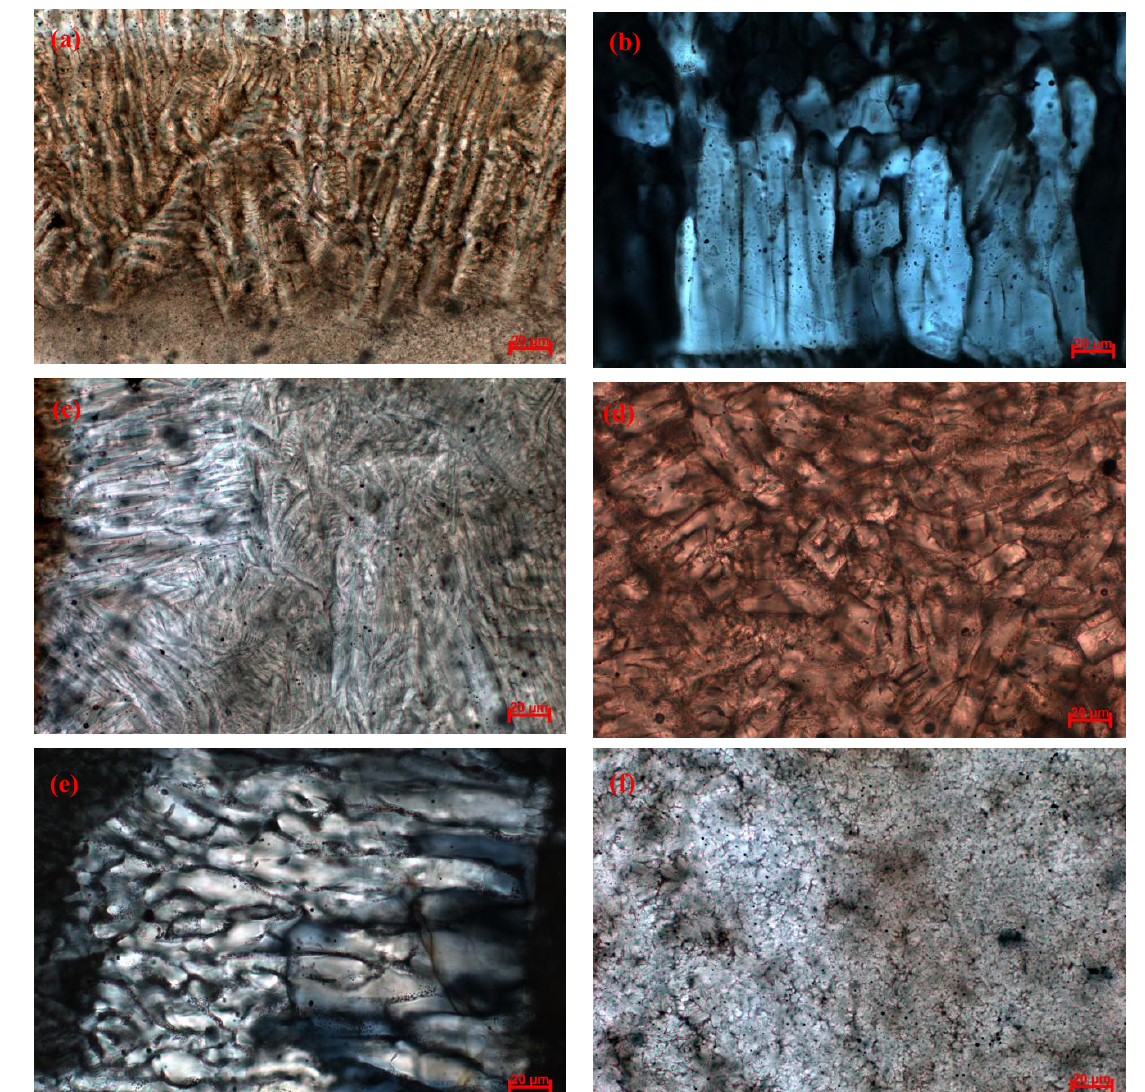
Figure 4. Mineralogical structures in flux films: ( a ) akermanite in film 1; ( b ) cuspidine in film 1; ( c ) akermanite in film 2; ( d ) akermanite in film 3; ( e ) cuspidine in film 3; ( f ) akermanite in film Table 4. Mineralogical compositions, proportions, and crystallization ratio of flux films (vol%).